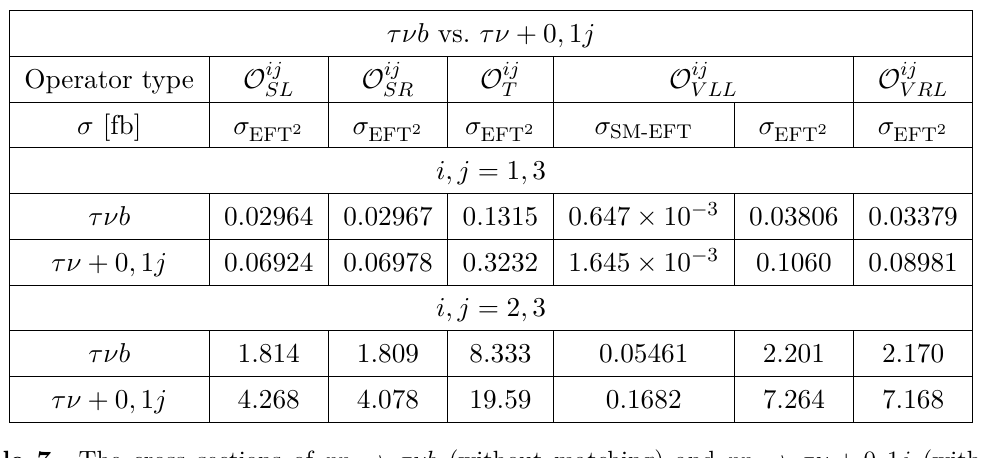
Table 6 . The cross sections of pp → τν (without matching) and pp → τν +0 , 1 j (with the matching √ up to one jet in 5-flavor scheme) at s = 13 TeV. The interference term, σ SM-EFT , and quadratic term, σ , are those in eq. (2.3). The numbers in table are after imposing the cuts in the CMS EFT 2 analysis.